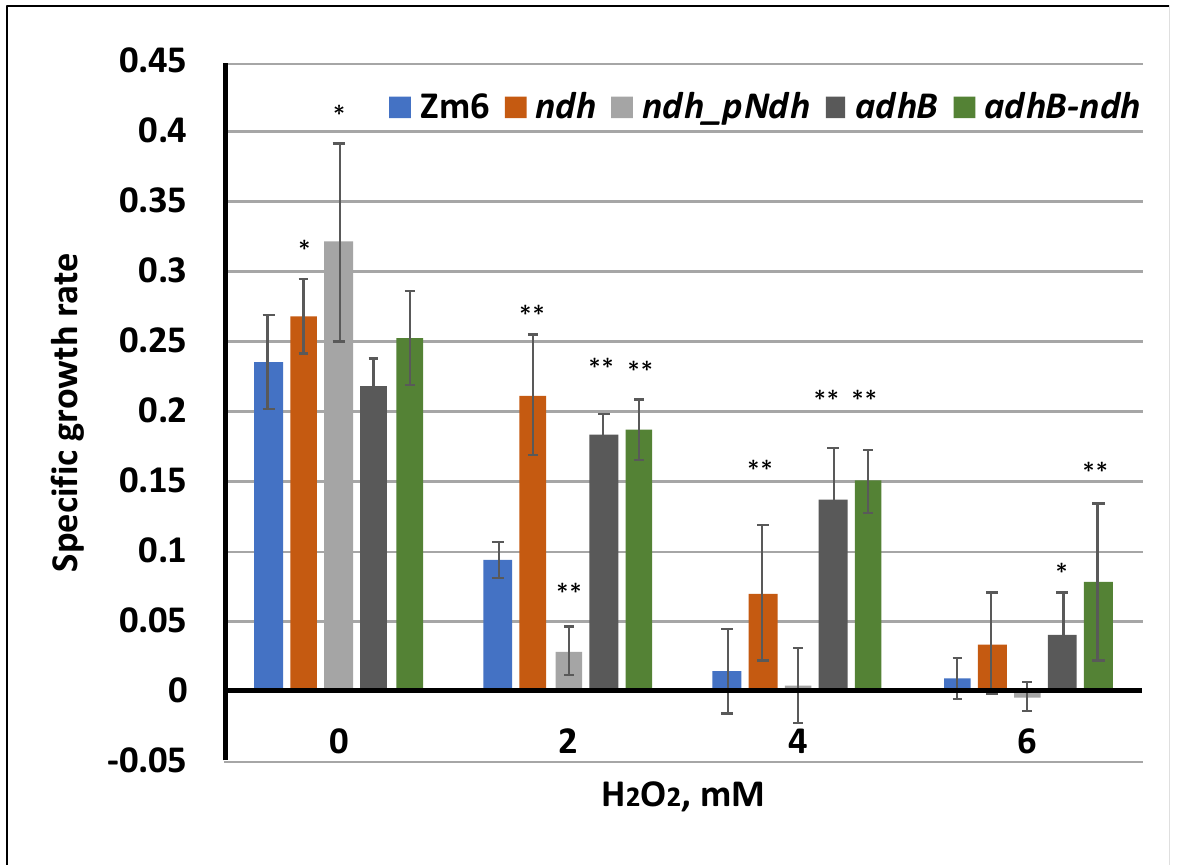
Figure 2. The average specific growth rate (h −1 ) of the wild type and mutant strains during a period of 6 h after transferring of exponentially growing cells to fresh growth medium, supplemented with hydrogen peroxide. At each H 2 O 2 concentration statistical significance of the differences between the Zm6 and mutant growth is shown: * p < 0.05; ** p < 0.01.